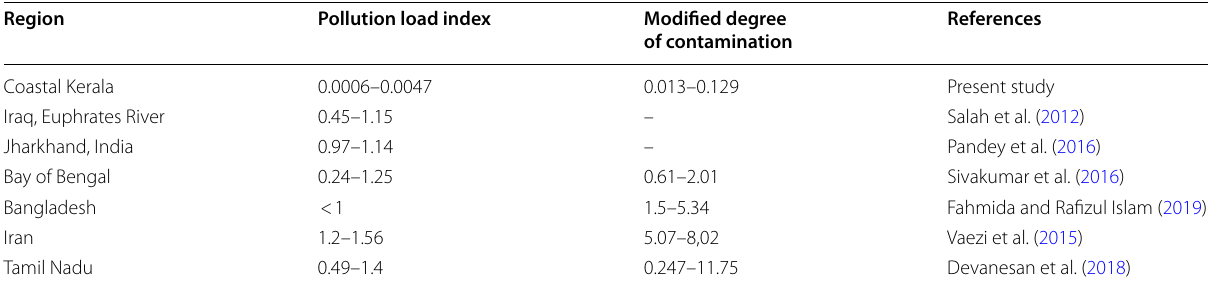
Table 16 Comparison of pollution load index and modified degree of contamination with other regions